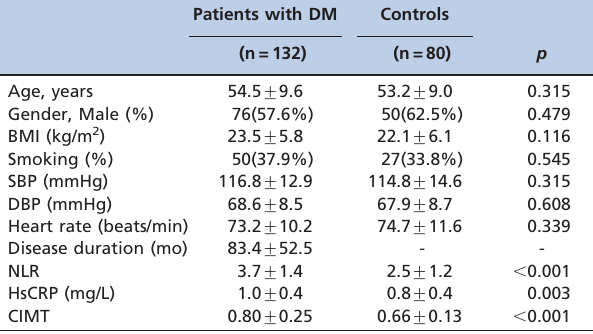
Table 1 - Clinical and laboratory characteristics of the study population.